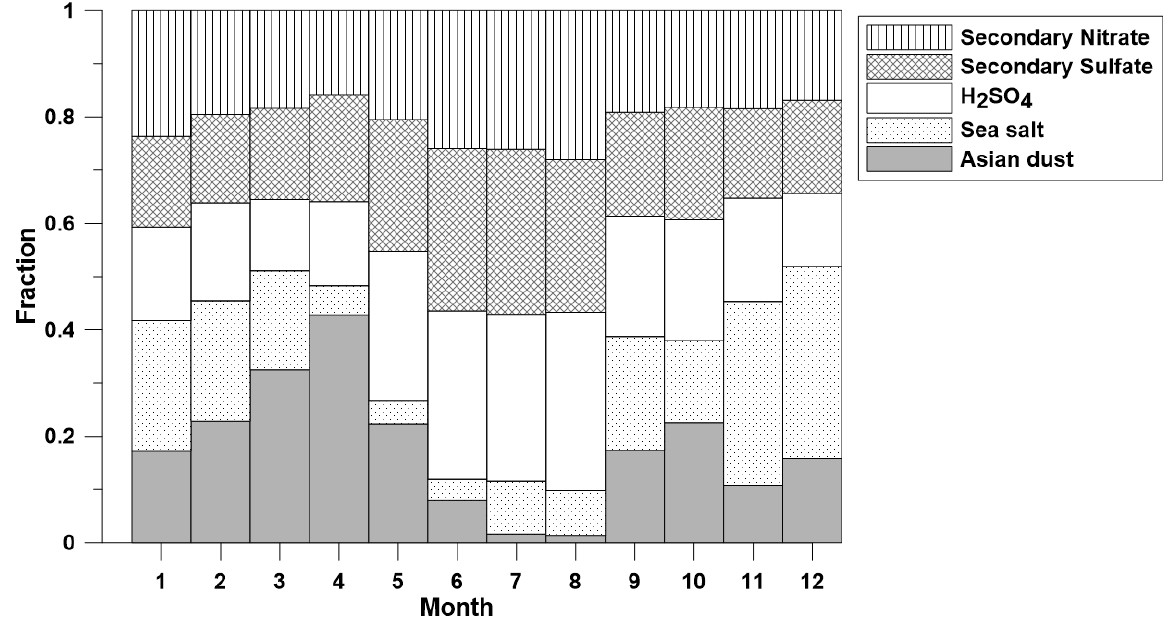
Figure 8. Temporal variations in the five source